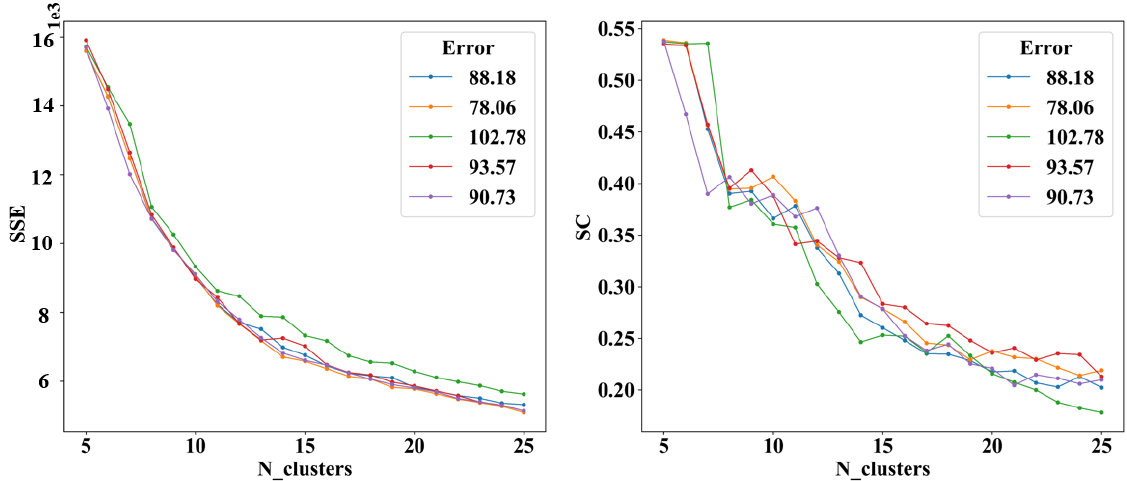
Figure 5. Clustering effect of departure trajectories under different reconstruction errors.